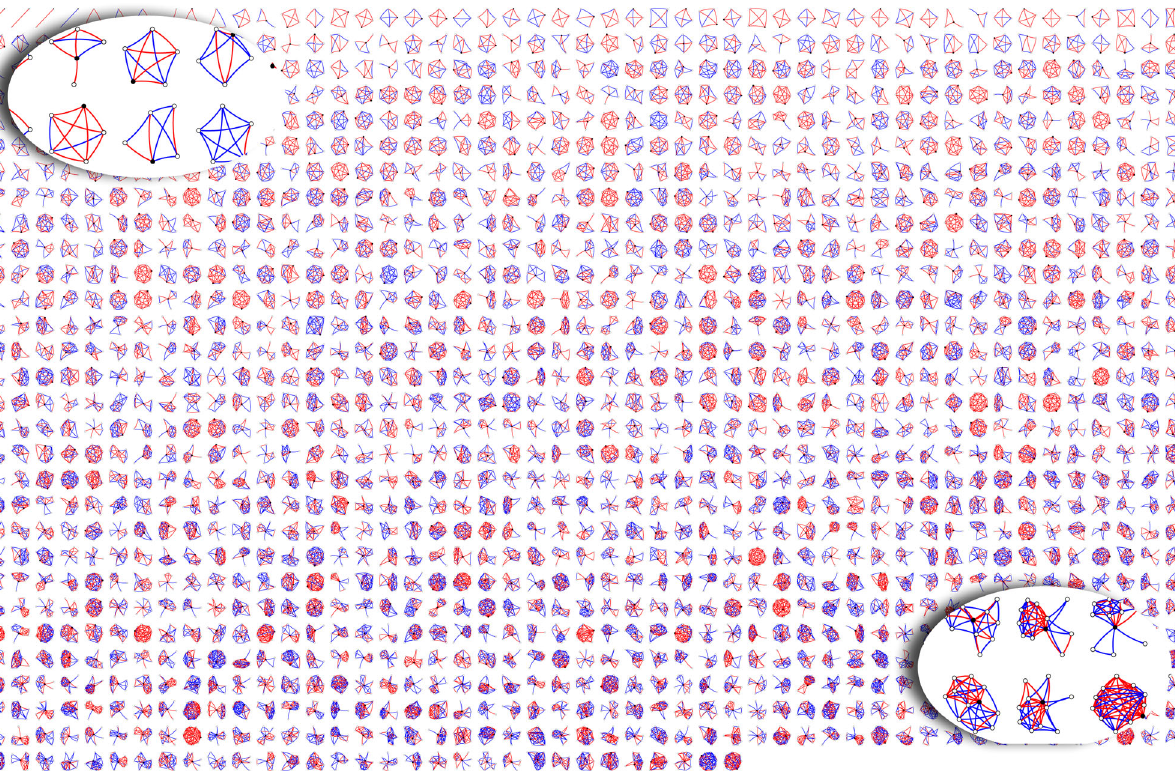
Fig. 2 Structure of participants ’ personal social network. Each small network has a black circle that represents the participant who is surrounded by white circles who are the network members. The lines connecting the circles are red if the relationship is strong and blue if the relationship is weak. Networks are arranged from the smallest (top left) to the largest (bottom